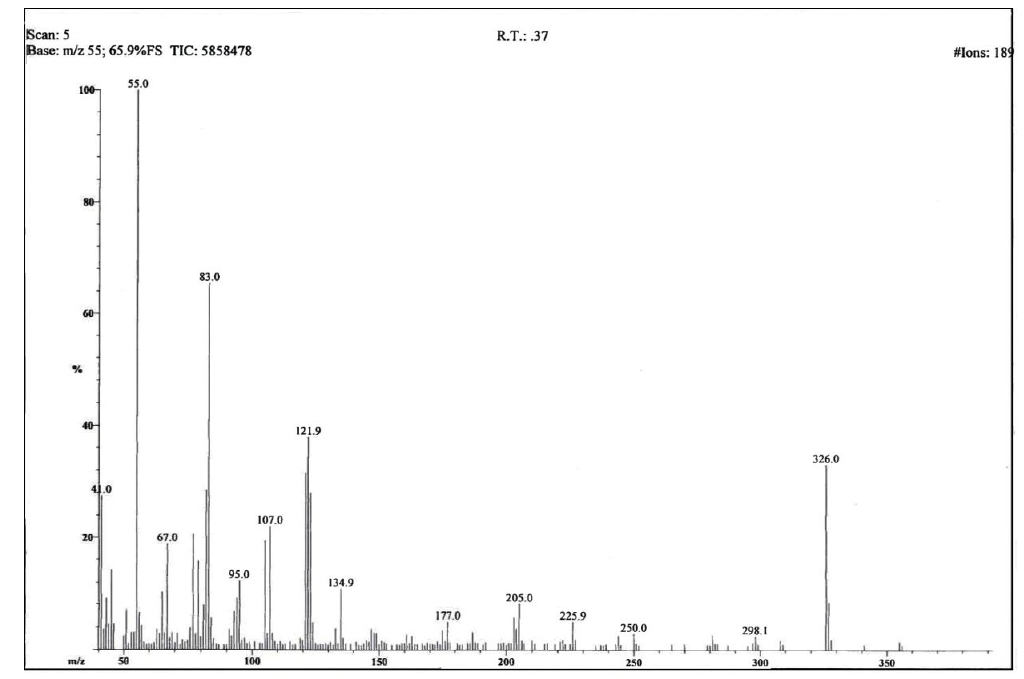
Figure S1: E.I mass spectrum of dialdehyde monomer m -HOB